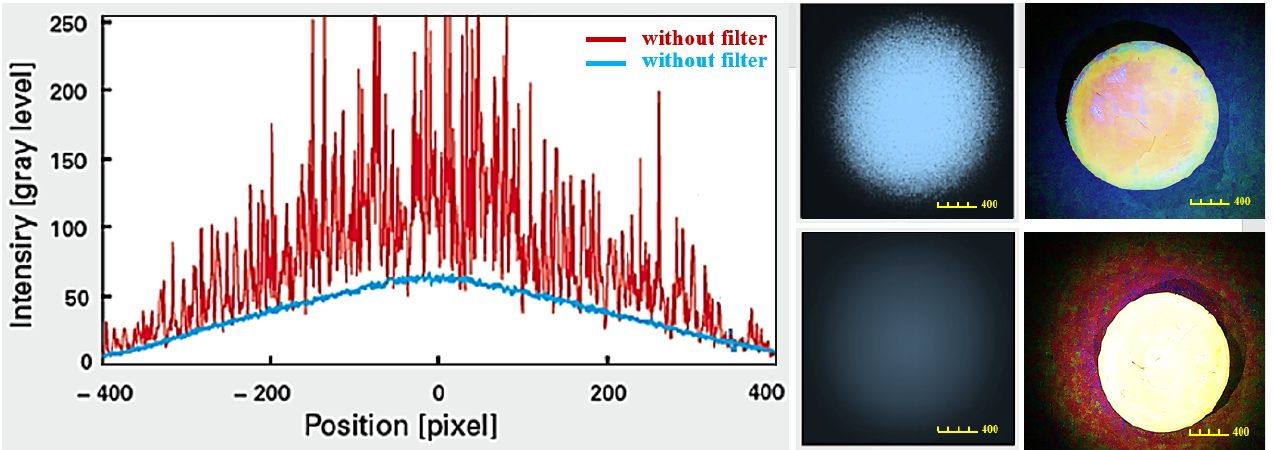
Figure 19. ROI numerical analysis of phantom experiment results for specular reflection removal.